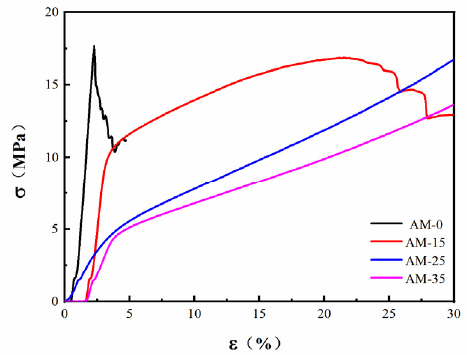
Figure 13. Uniaxial compressive stress–strain curves of the 3 d specimen.